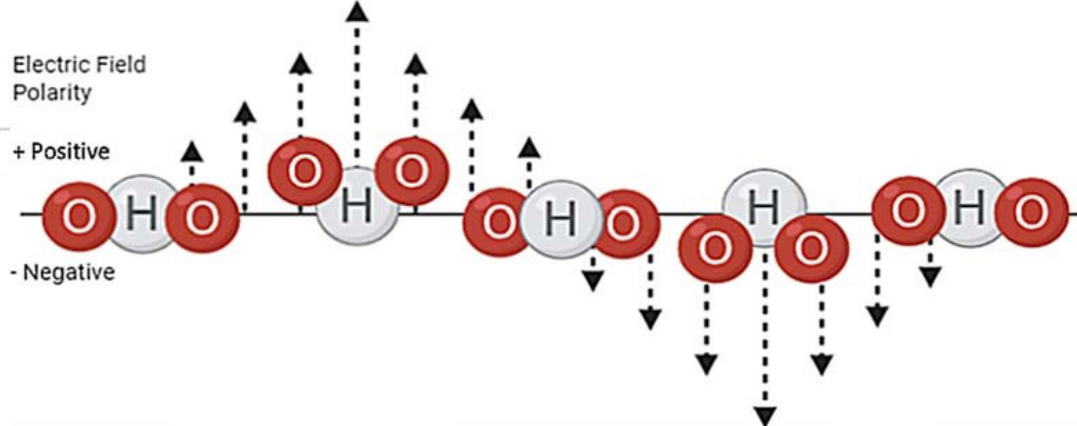
Figure 4. Water molecules rotation to align with an oscillating electric field. The electric field in a microwave oscillates between positive and negative polarity, the water molecules negative oxygen and positive hydrogen particles rotate to abide by the laws of attraction. This rotation generates thermal energy.